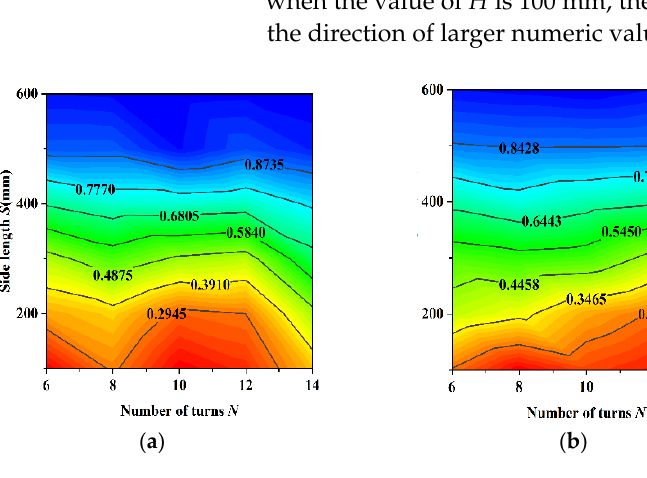
Figure 6. Variation of the uniformity coefficient α with N : ( a ) H = 100 mm; ( b ) H = 150 mm; ( c ) H = 200 mm.